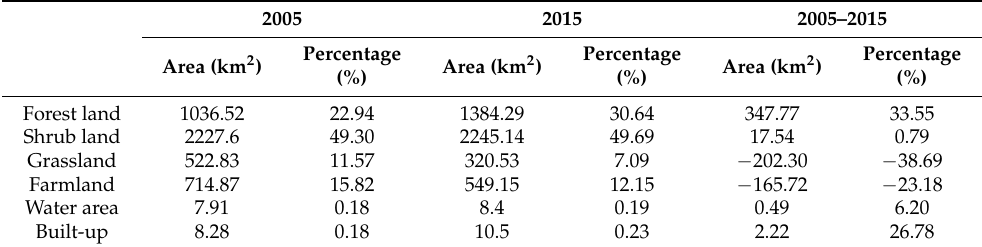
Table 2. Land-use changes in Huanjiang County from 2005 to